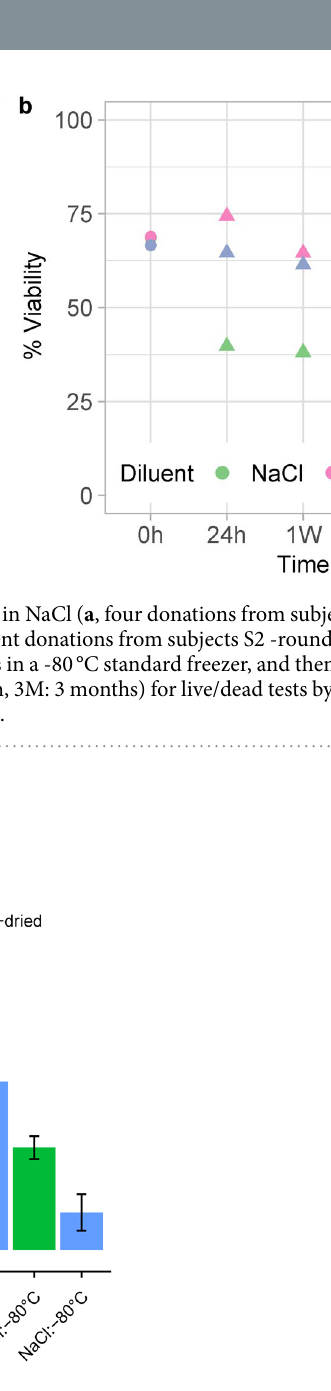
Figure 8. Percent live bacteria in fresh, frozen or further freeze-dried purified microbiota in either NaCl, or MD, or TR. Samples are ranked in descending order of viability (live/dead test by flow cytometry). Statistics are detailed in Supplementary Table S1. The black bars are 95% confidence